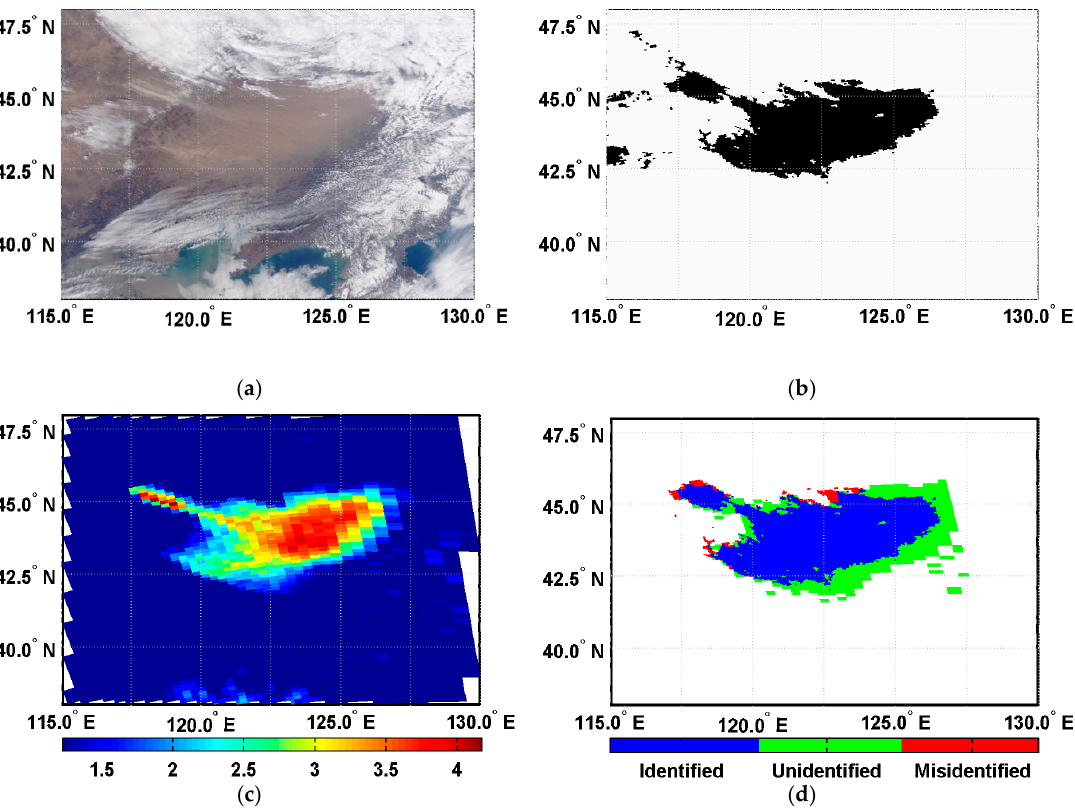
Figure 9. Validation of dust image with OMI UVAI (ultraviolet Aerosol Index) on 23 October 2007 at UTC time 04:55. ( a ) RGB (Red Green Blue) image; ( b ) dust image; ( c ) OMI UVAI image; and ( d ) the difference between UVAI and dust image.